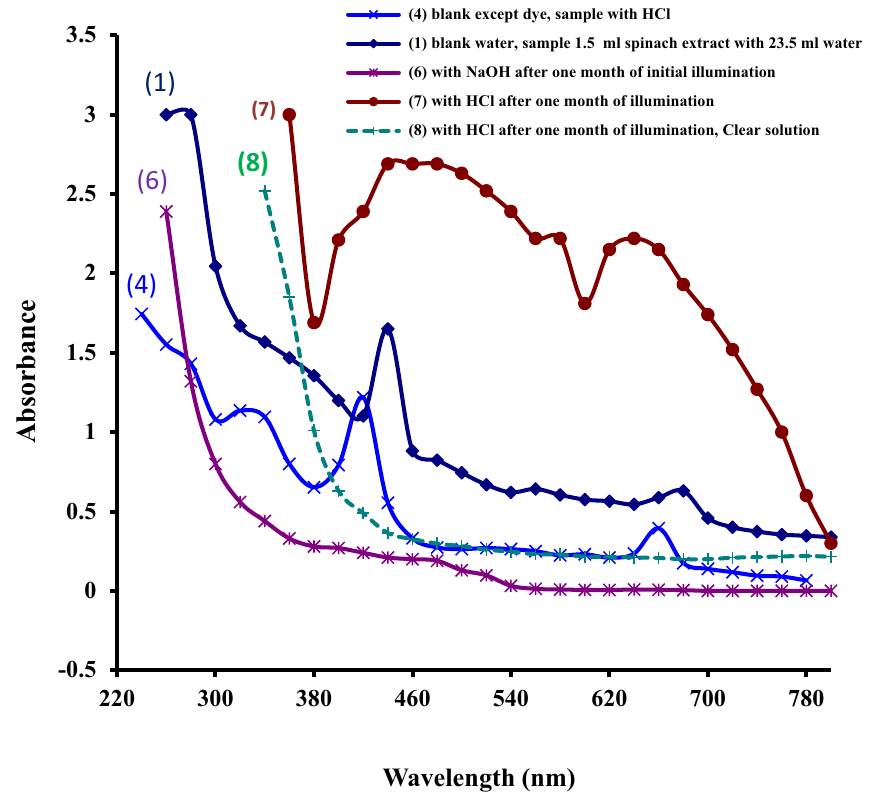
Figure 3. (1) Post-second time illumination spectra of the extract in the presence of NaOH, NaLS and Fructose [curve line 6, main spectral property: both reference and sample solutions were illuminated on 2nd day of preparation, and re-illuminated on 24th day, spectra after re-illumination, no peak at any wavelength, A 0 at 700 nm and higher λ, A ≈0 from 540 to 700 nm, absorbance rises regularly from 540 nm towards lower λ]; (2) Post-illumination spectra of the extract in the presence of HCl, NaLS and Fructose. [curve line 7, main spectral property: absorbance at all λ was highly elevated, broad band at 640 nm (A 2.22 ),very broad band at 440– 480 nm (A 2.69 ), a shoulder band at 540 nm (A 2.22 )]; and (3) Post-illumination spectra of the spinach extract in the presence of HCl, NaLS and Fructose: spectra of clear and transparent layer [curve line 8, main spectral property: no peak at any λ, A 0 at 700 nm and higher λ, A ≈0 from 540 to 700 nm, absorbance rises regularly from 540 nm towards lower λ].